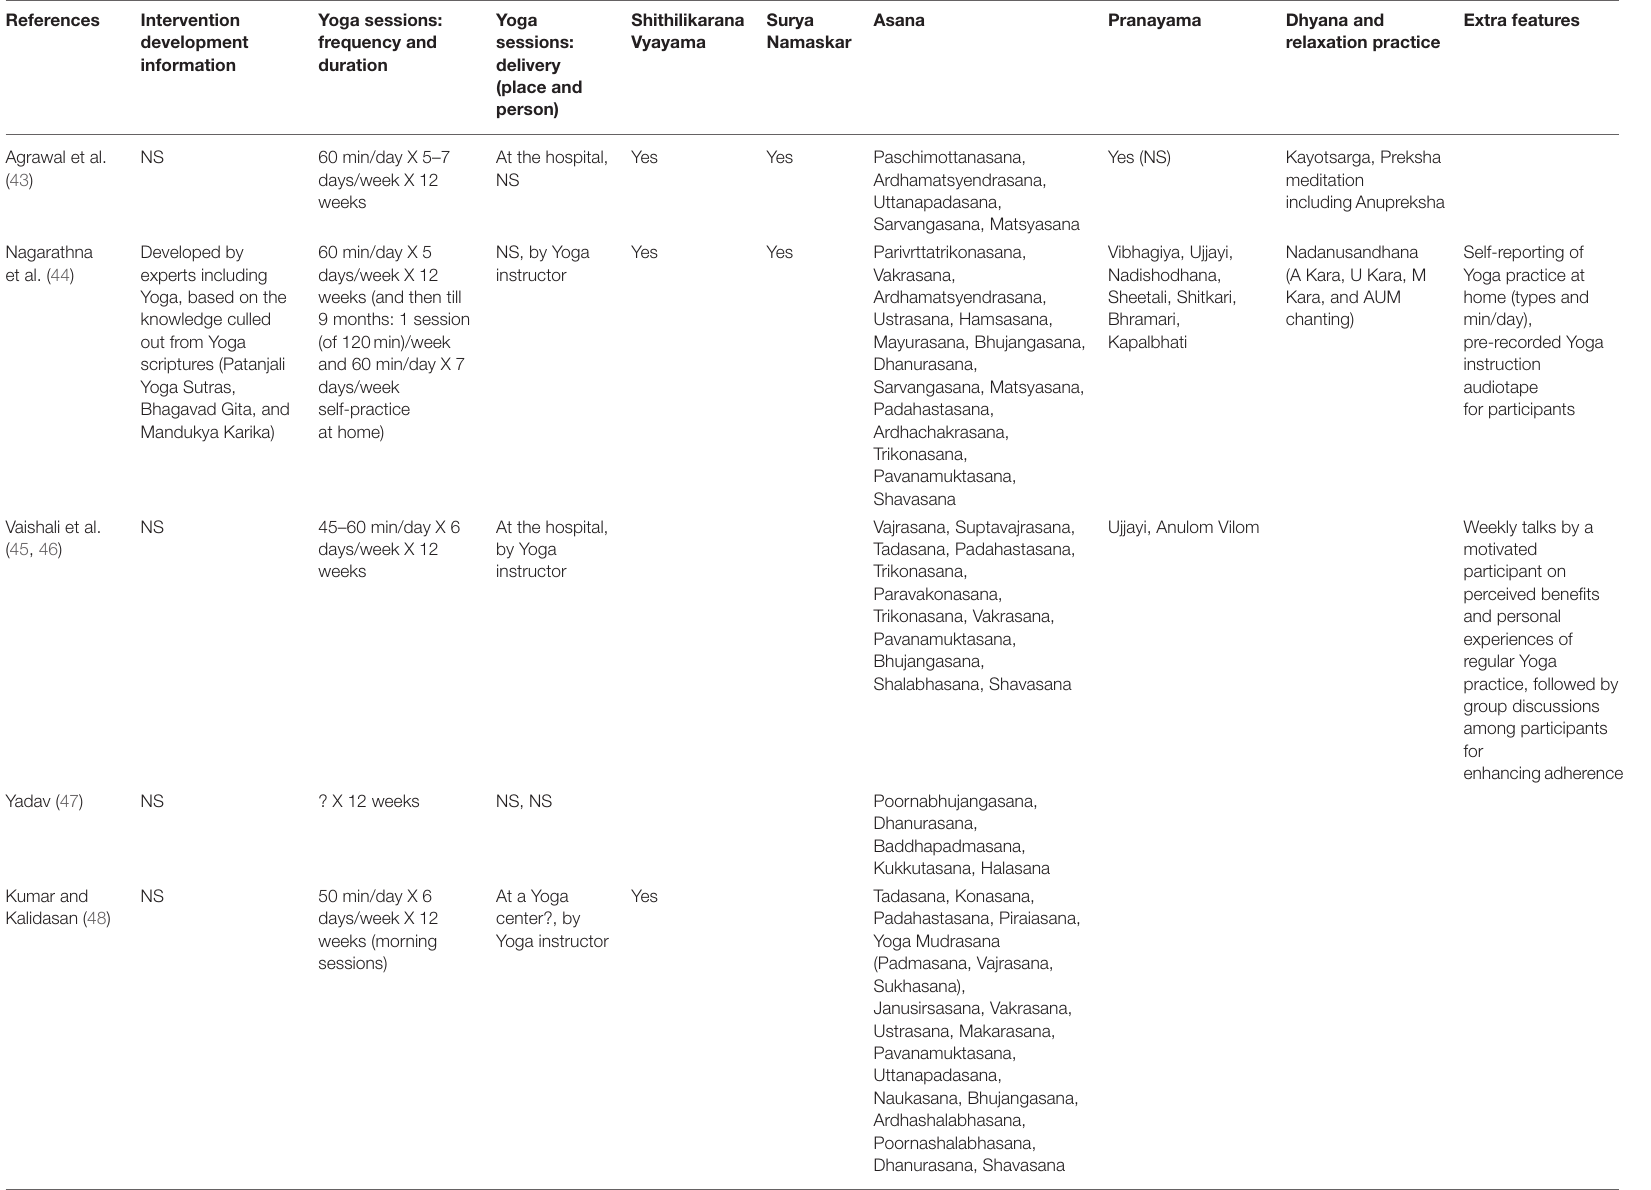
TABLE 1 | Intervention details of the included